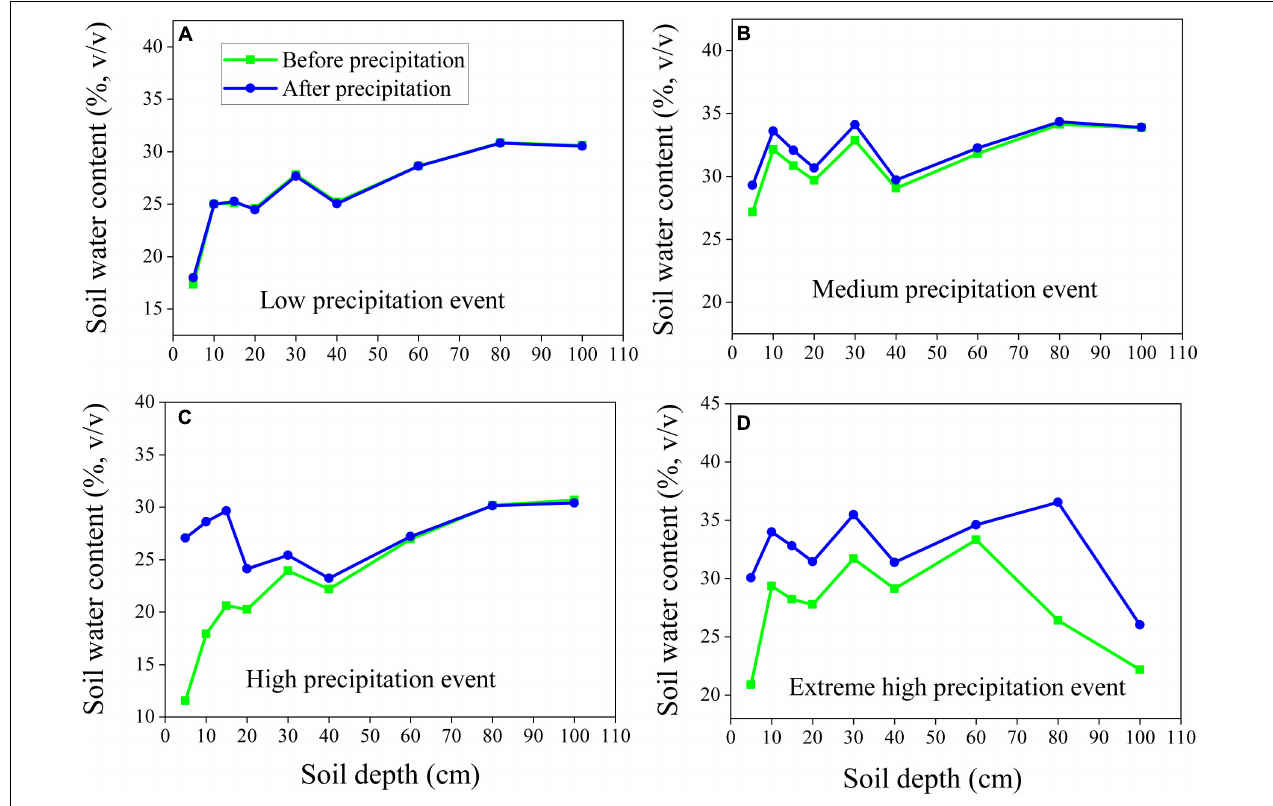
FIGURE 8 | The depth of soil water infiltration of alpine shrub at low precipitation event (A) , medium precipitation event (B) , high-precipitation event (C) and extremely high-precipitation event (D)